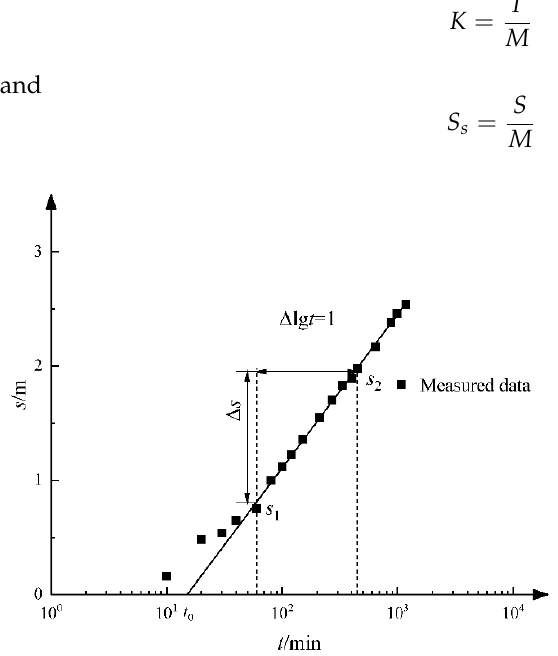
Figure 3. Schematic diagram of straight-line method.